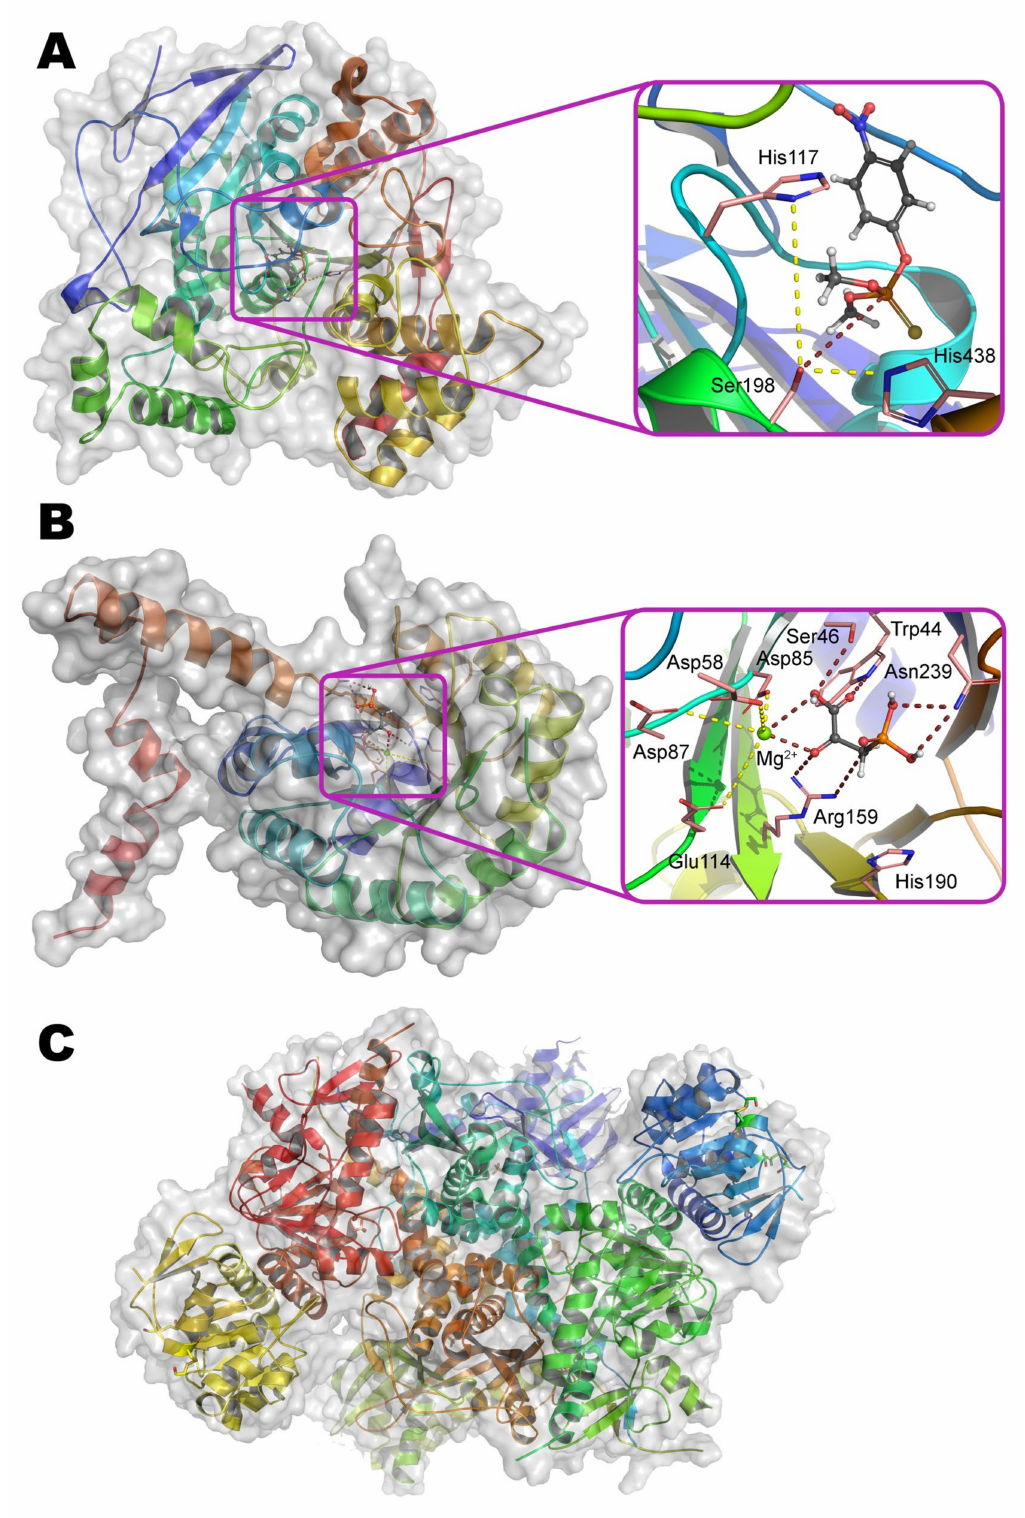
Figure 16. The structure of modified AChE ( A ), PEPP ( B ), and eight-subunit complex of C-P lyase ( C ) according to X-ray diffraction data (PDB 2XMG, 1S2V, and 4XB6, respectively). The entrance to the active centers of the enzymes is framed, and their structures are shown in detail within insets. The binding of the substrate methyl parathion ( A ) and phosphonopyruvate ( B ) was determined as previously. The coordination bonds of metal ions with amino acid residues in active centers, as well as with labile groups of the substrate are shown by a dashed